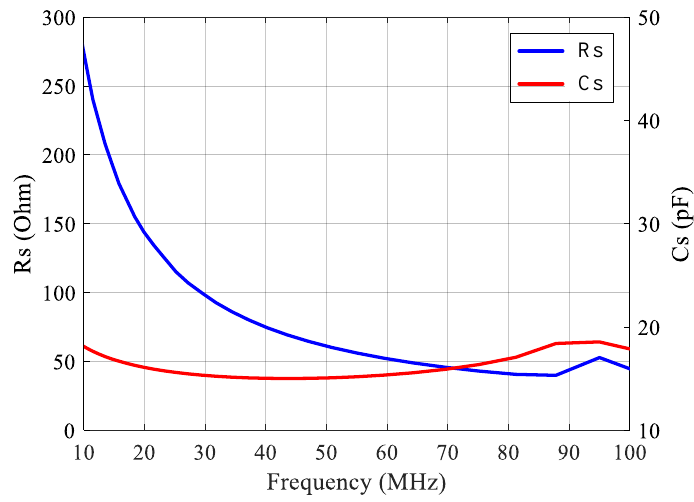
Figure 2. Measured output impedance of the PVDF transducer.